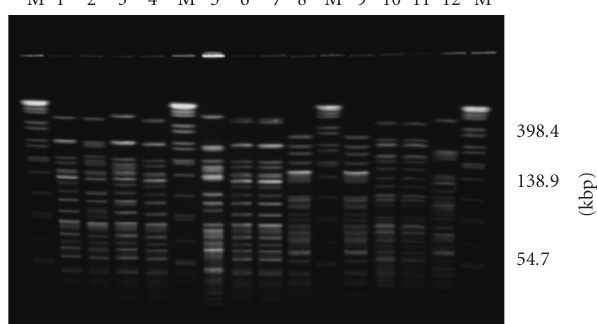
Figure 2: Not I-PFGE profiles of representative Malaysian V. cholerae of di ff erent serogroups. M: Xba I-digested S. ser. Braen- derup H9812 standard; lanes 1–7: strains of O1 serogroup; lanes 8–12: strains of non-O1/non-O139